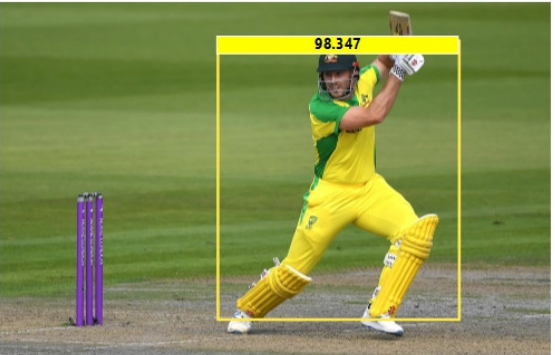
Figure 5. Bounding box showing detected person after application of aggregated channel features algorithm.